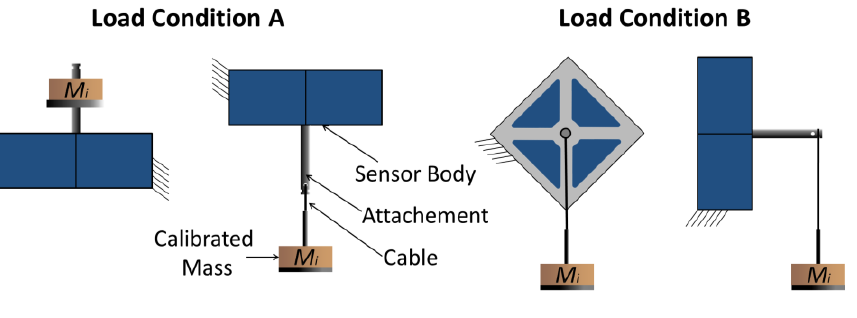
and C : RC low pass filter components ( a ); picture of the f f